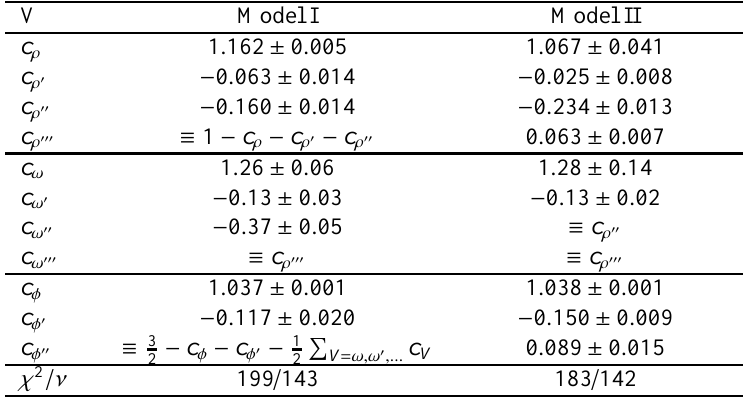
Table 1. The fitted values of the coe ffi cients C V in two